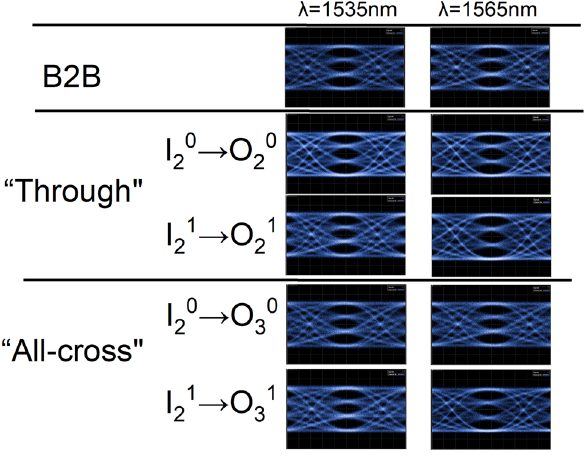
Figure 8: Eye diagrams for 50 Gb/s data transmission at 1535 and 1565 nm, respectively.